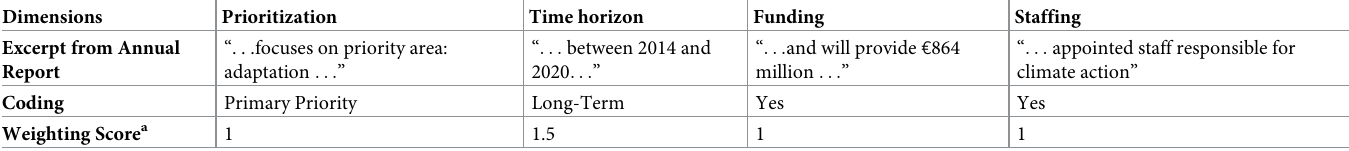
Note : This table includes the variables coded by the author from the IOs’ annual reports included in the IO engagement dataset described above. a The final index score was calculated by first adding the scores, as exemplified in the table, and then by averaging all responses in one year per IO. For further details on operationalization, scoring, and coding, see S1